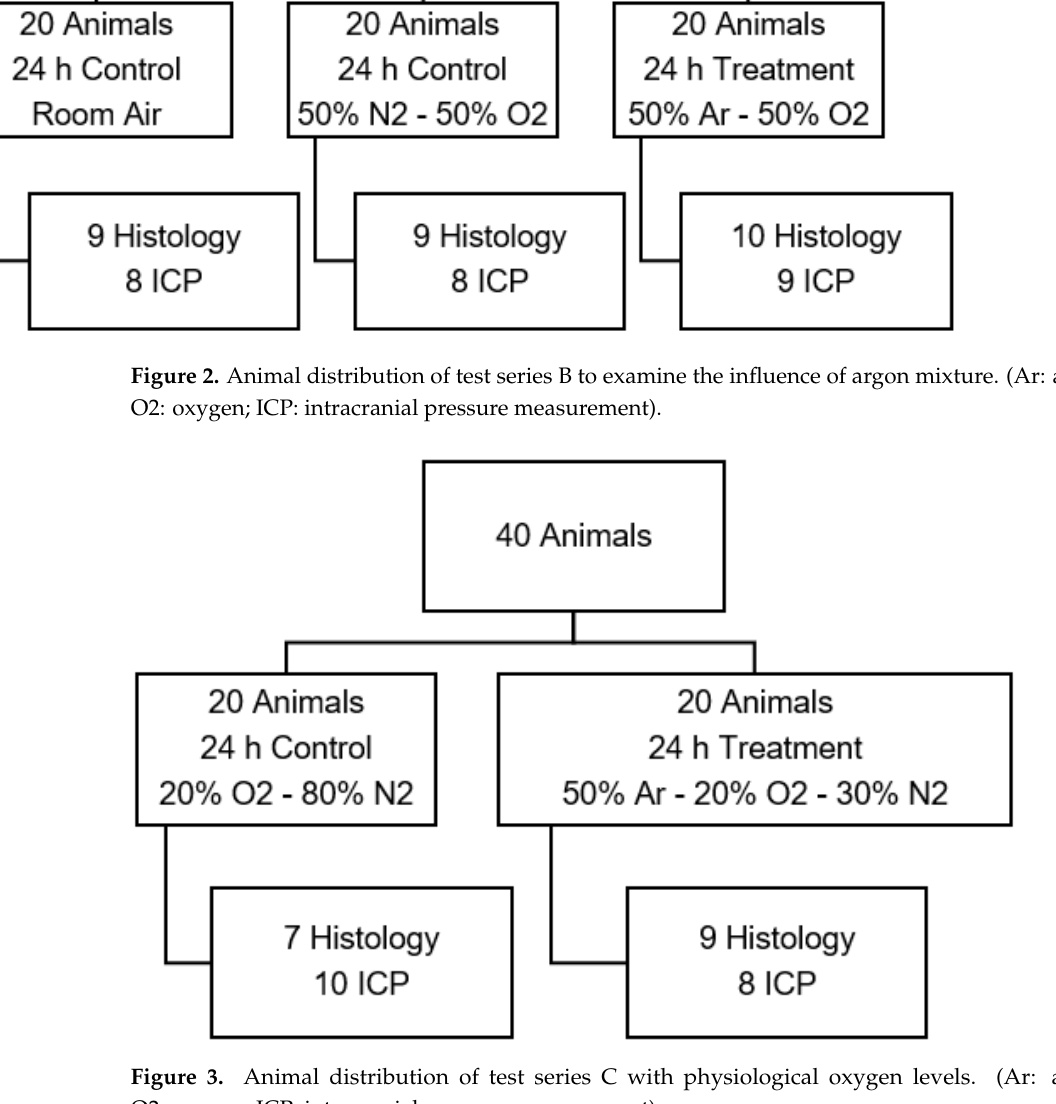
Figure 3. Animal distribution of test series C with physiological oxygen levels. (Ar: argon; O2: oxy- gen; ICP: intracranial pressure measurement).